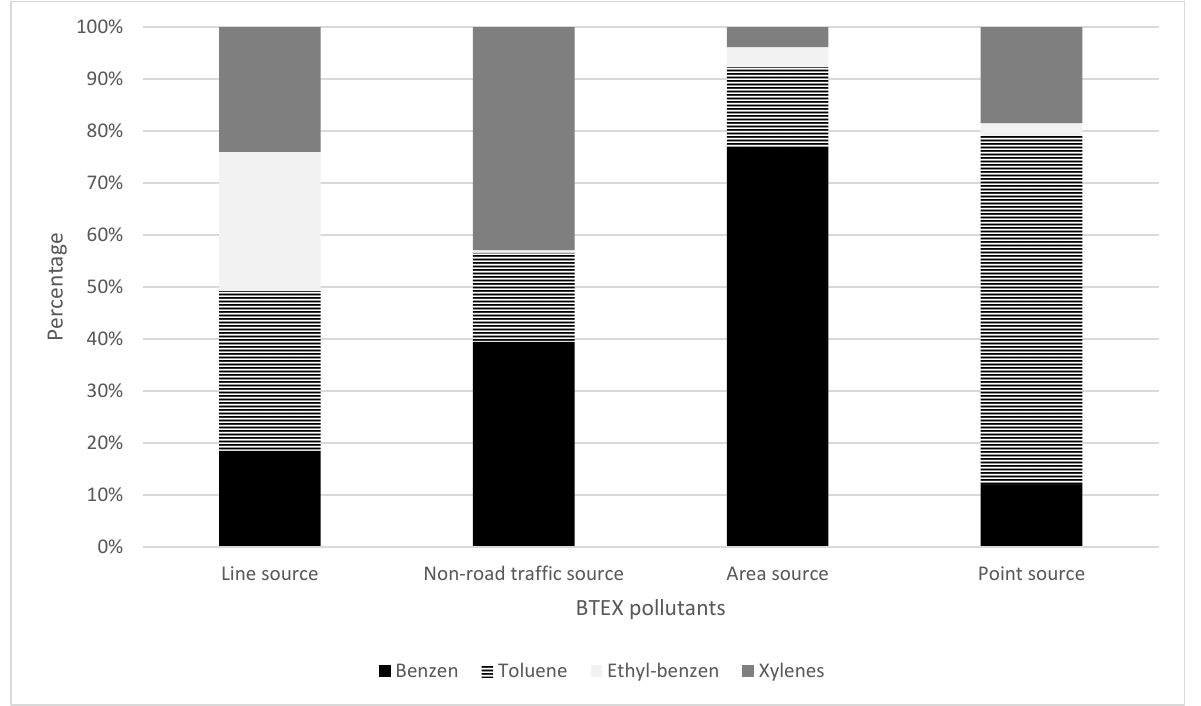
Figure 4. Contribution of each BTEX pollutant to the EI of different sources in HCMC. We indicated the contribution of primary pollution sources in Table 8. Among emis ‐ sion reasons, motorcycles were the most significant contributor to HCMC air pollution, being responsible for 93%, 90%, 98.9%, and 91.5% of benzene, toluene, ethylbenzene, and xylene, respectively. Cars contributed 5%, 6%, 0.8%, and 6.5% of benzene, toluene, ethylbenzene, and xylene, respectively. For LDVs, the emissions from benzene, toluene, ethylbenzene, and xylene accounted for 1%, 2%, 0.2%, and 1.9%. The main reasons for point sources were metal production, which had 1%, 2%, and 0.1% for benzene, toluene, ethylbenzene, and xylenes emissions. The area source had a minority emission of BTEX. Table 8. Contribution of some primary activities in BTEX emission in Ho Chi Minh City .